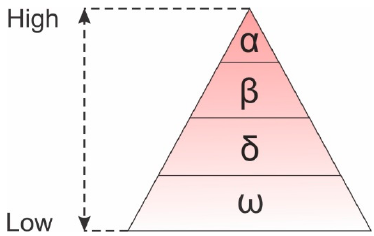
Figure 6. Flowchart of the Whale Optimization Algorithm (WOA) algorithm.